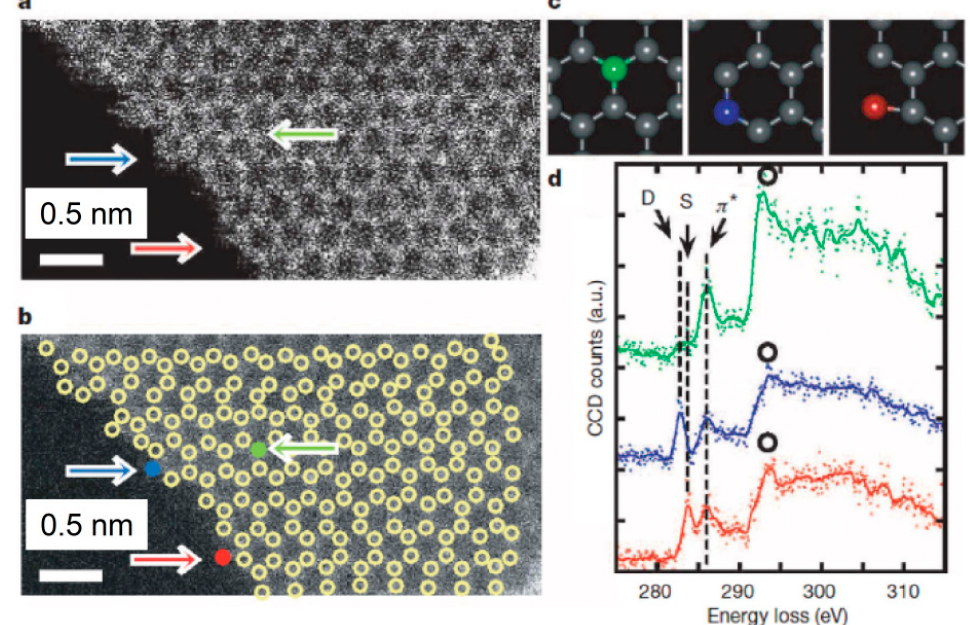
Figure 40. Imaging and spectroscopy of graphene edge. ( a ) ADF STEM image of a single graphene layer at the edge region. No image-processing has been done. Atomic positions are marked by circles in a smoothed image ( b ). Green, blue, and red spectra correspond to the normal sp 2 carbon atom, a double-coordinated atom, and a single-coordinated atom, respectively. These different states of atomic coordination are marked by coloured arrows in ( a , b ) and illustrated in ( c ). ( d ) Electron energy loss spectroscopy (EELS) of carbon K (1s) spectra taken at the colour-coded atoms indicated in ( b ). Reproduced with permission from Suenaga et al. [132]. Copyright Nature,